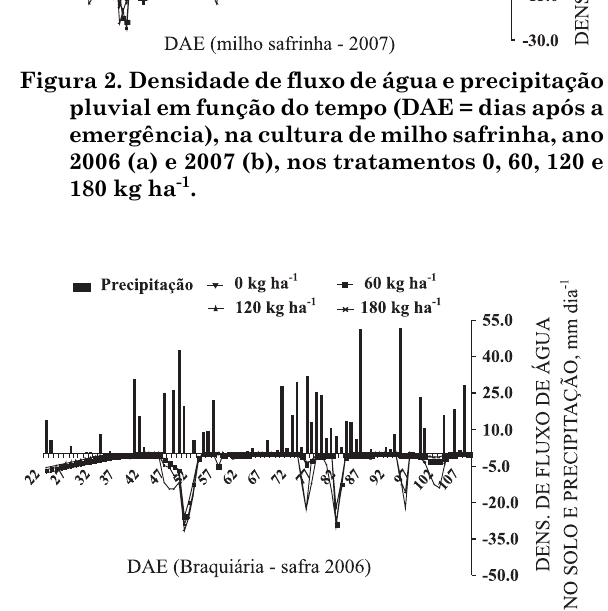
Figura 3. Densidade de fluxo de água e precipitação pluvial em função do tempo (DAE = dias após a emergência), na cultura da braquiária, safra 2006, nos tratamentos 0, 60, 120 e 180 kg ha -1